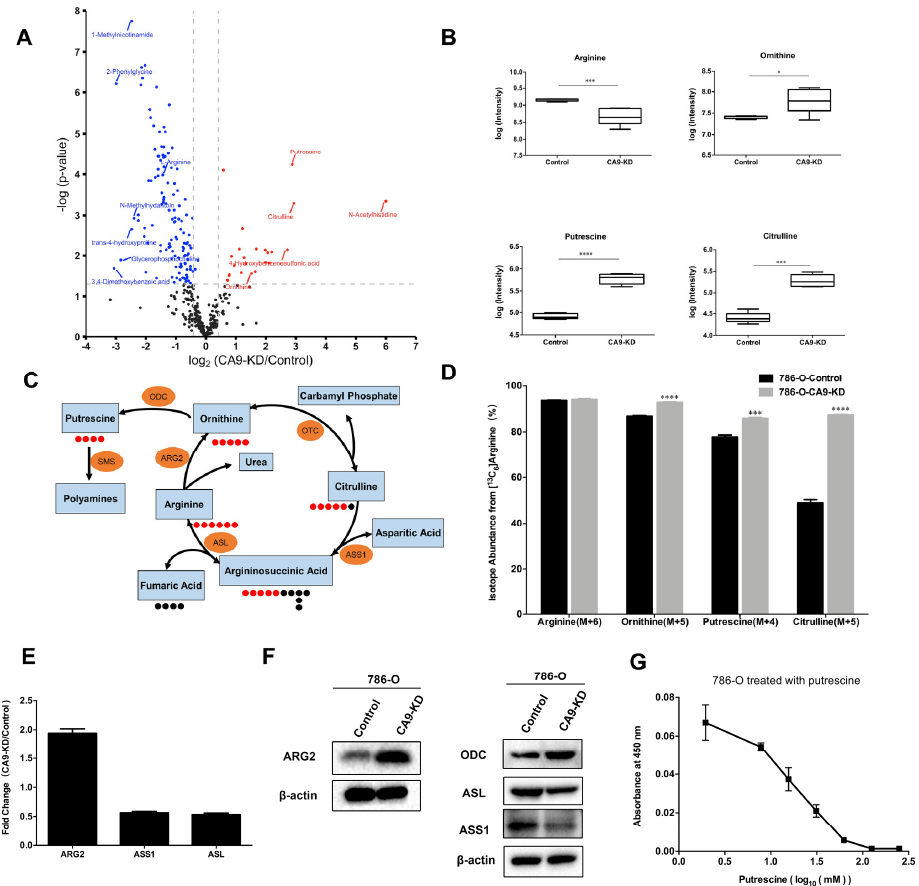
Figure 4. CA9 knockdown increases putrescine production from arginine and inhibits cell growth. ( A ) A volcano plot of metabolites in 786-O-CA9-KD cells compared with control cells. The plot displays the fold changes of metabolite contents between CA9-KD cells and control cells against the p -values ( − log10). Blue and red dots indicate the decreased and increased metabolites with significant di ff erence ( p -values < 0.05, fold changes ≤ 0.75 or ≥ 1.33), respectively. ( B ) Boxplots of metabolite intensity in putrescine synthesis pathway in CA9-KD cells and control cells ( n = 5, mean ± SEM). ( C ) Schematic representation of putrescine biosynthesis from 13 C 6 -arginine; red dots represent heavy carbon with 13 C labeling while black dots represent light carbon ( 12 C). The blue rectangles indicate metabolites and orange ovals indicate related enzymes. ODC, ornithine decarboxylase; ARG2, arginase 2; ASS1, argininosuccinate synthase 1; ASL, argininosuccinate lyase; SMS, spermine synthase; OTC, ornithine carbamoyltransferase. ( D ) Isotope relative abundance of M + 5 ornithine, M + 5 citrulline, and M +